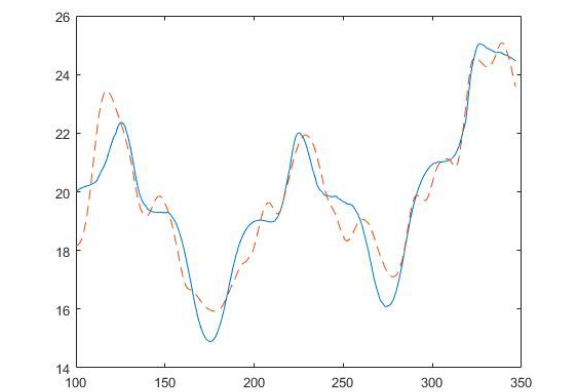
Fig. 24. Trajectory approximation of one of 100 cells using the first 10 principal components in geometry A.